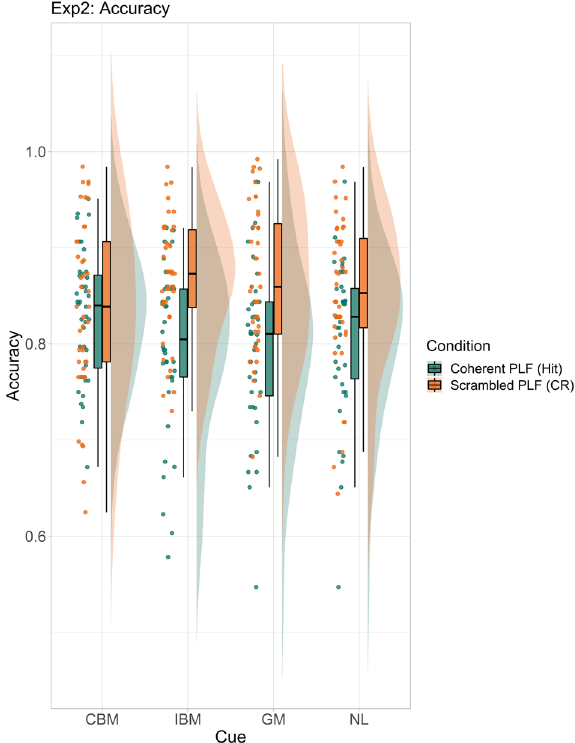
Figure 4. Accuracy (raw data) for coherent (hit) and scrambled (correct rejection; CR) PLF conditions for Experiment 2. Cue names are as follows: CBM congruent biological motion, IBM incongruent biological motion, GM general motion, NL no language.